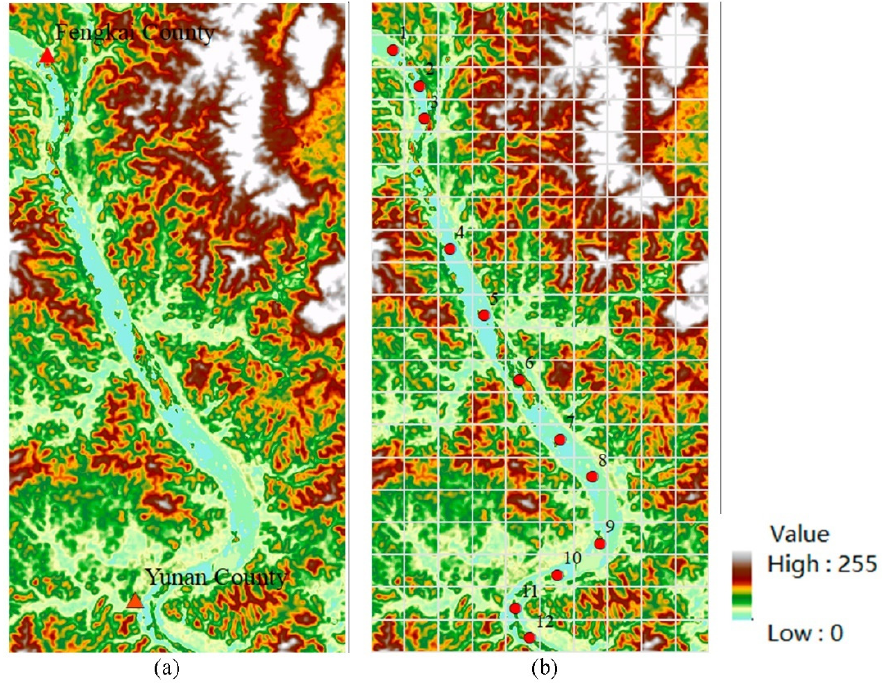
Figure 12. Environmental digital elevation model image.